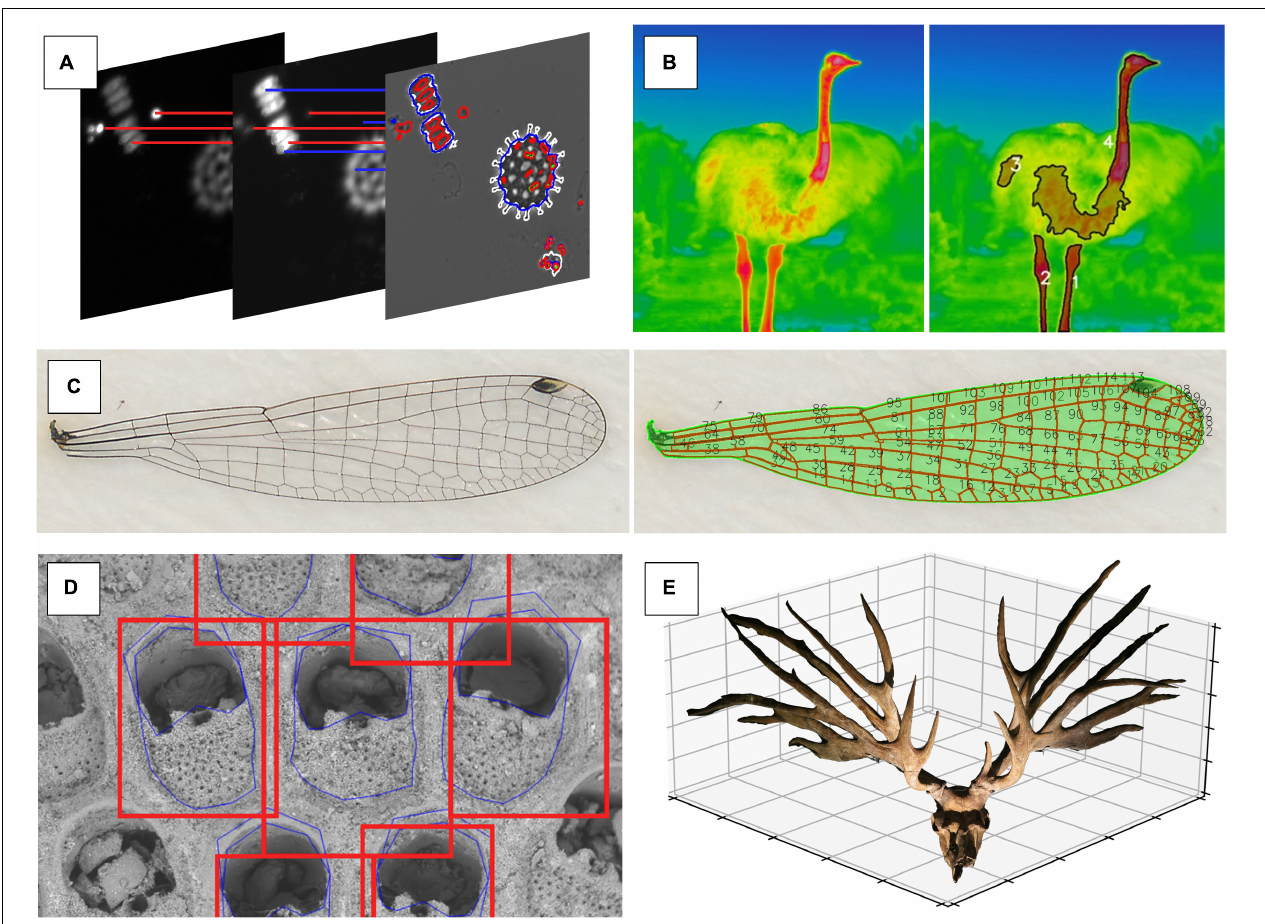
FIGURE 6 | Different types of high dimensional phenotypic data that are collected using a fully or semi-automatic computer vision approach. (A) Morphology and fluorescence traits of phytoplankton communities are represented through a combination of shape features (e.g., circularity, perimeter length, and area) and texture features (e.g., blob intensity and distribution within the cell) from images showing fluorescence intensity (images by Irene Gallego). (B) In ostriches ( Struthio camelus ), surface temperatures of bare body parts without feathers (necks and legs) are detected using signal processing (image by ES). (C) Signal processing approach that captures individual domains of a damselfly wing via thresholding (image by MT). (D) Ensemble-based approach to shape prediction of individual zooids within a bryozoan colony (image by AP). (E) 3D image of the skull of extinct deer Eucladoceros dicranios from which we can measure linear, area, and volumetric measurements of antler features (image by